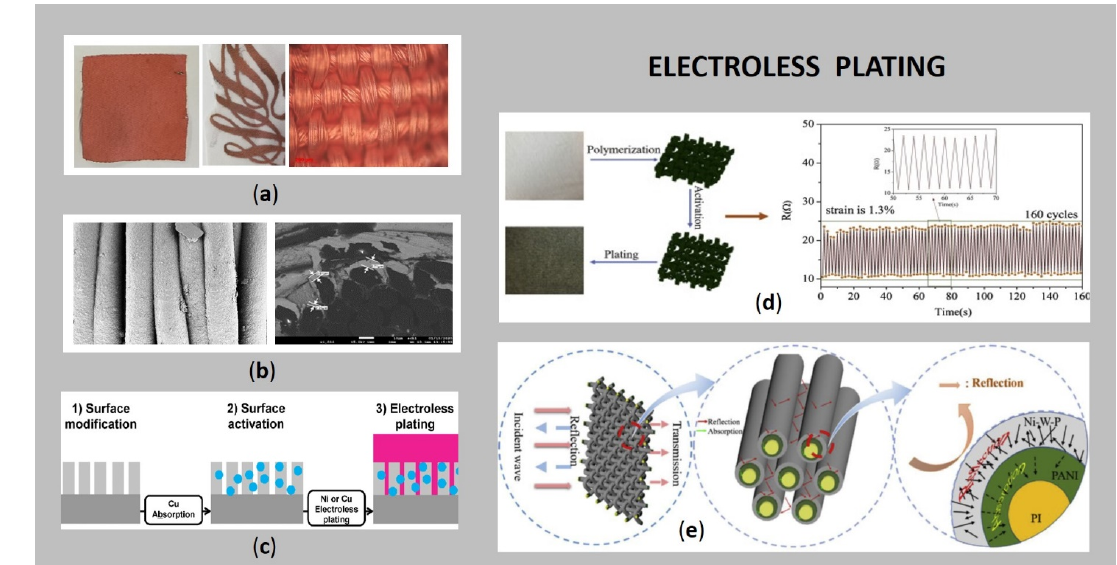
Figure 4. ( a ) Electroless Cu plated samples: the whole surface, pattern, and corresponding optical microscopy image; ( b ) SEM images of electroless Cu plated sample: longitudinal view and cross-sectional; ( c ) illustration of electroless plating process (reprinted with permission from Ref. [69] Copyright 2021, American Chemical Society); ( d ) sheet resistance during periodic stretching and releasing test at different strain levels, using a wearable strain sensor prepared by silver plated cotton/spandex blended fabric (reprinted with permission from Ref. [23] Copyright 2021, Elsevier); ( e ) the scheme of an EMI shielding mechanism of Ni-W-P/PANI/PI fabric (reprinted with permission from Ref. [61] Copyright 2021, Elsevier).